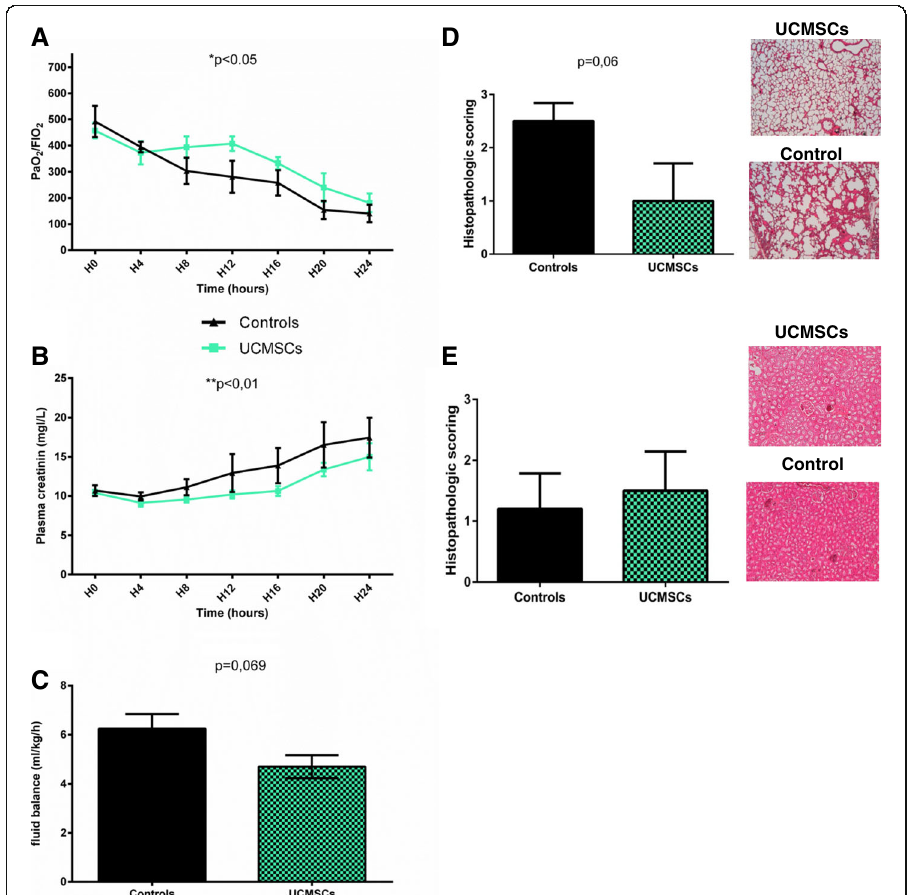
Fig. 3 UCMSCs attenuate sepsis-induced organ failure. Lung function was monitored by assessing the PaO 2 /FIO 2 ratio ( a ) and based on histology ( d ). Renal function was assessed by measuring plasma creatinine concentration ( b ), fluid balance ( c ), and by histological observation ( e ). For histological scoring, a score of 0 corresponds to an absence of anomaly, 1 reflects discrete anomalies, 2 corresponds to moderate anomalies, and 3 indicates severe anomalies. Histological images (hematoxylin-eosin staining, × 40 magnification) are representative of the respective conditions. * p <0.05; ** p <0.01; *** p <0.001; **** p <0.0001 versus control